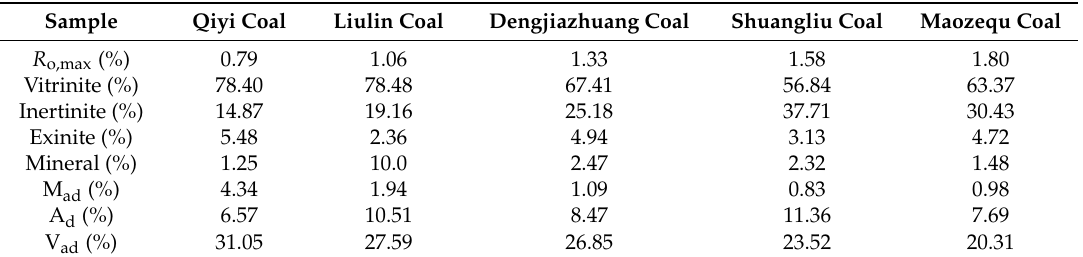
Figure 2. The flow chart of Sc-CO 2 extraction in this work.